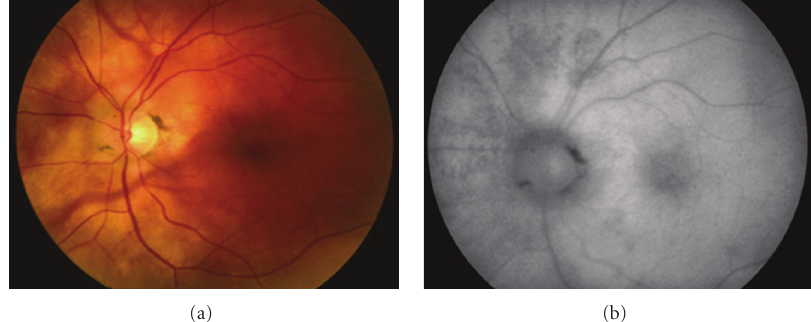
Figure 2: Images from the left eye of a 58-year-old woman with birdshot chorioretinopathy (patient 5). (a) Fundus colour photograph shows poorly pigmented fundus with scatter BSCR lesions nasal to the optic nerve. (b) Autofluorescence photograph shows scattered areas of RPE atrophy as hypoautofluorescent spots and as a linear pattern along the retinal